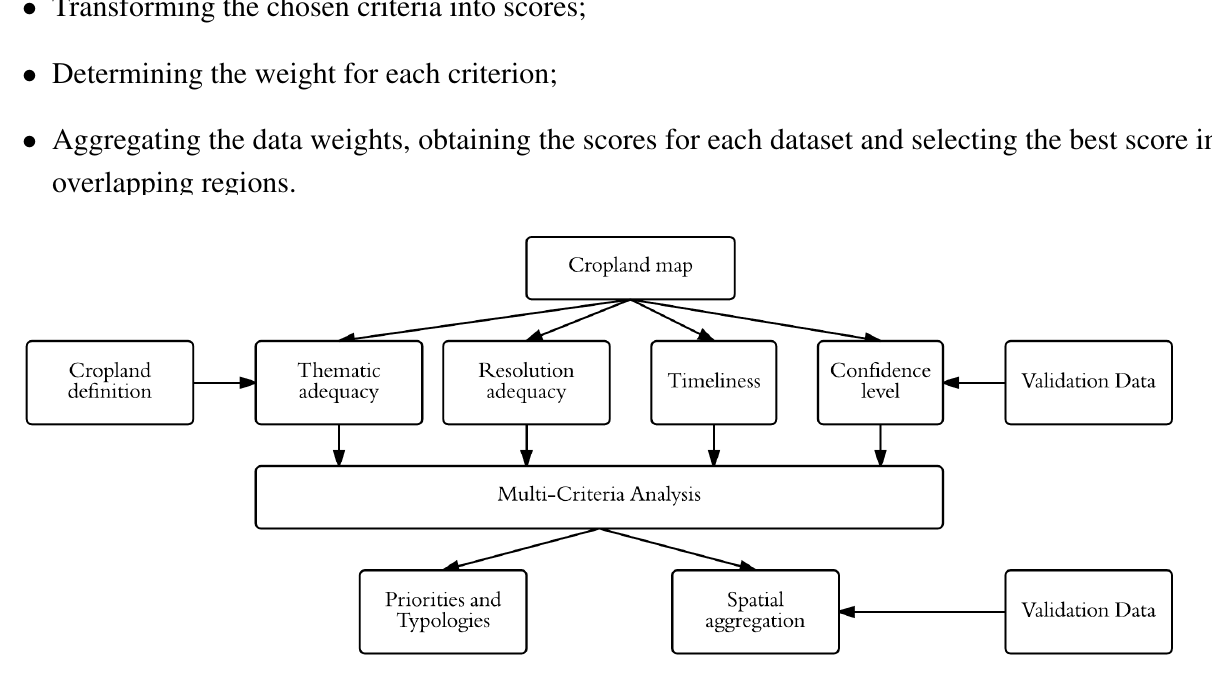
Figure 1. The analytical framework of the assessment is a systematic analysis of four criteria that characterize the fitness of a cropland map. The four criteria are the thematic consistency, the timeliness, the resolution adequacy and the confidence level. From this analysis, two outputs were derived: (1) a priority map for global cropland mapping; and (2) a Unified Cropland Layer combining the fittest